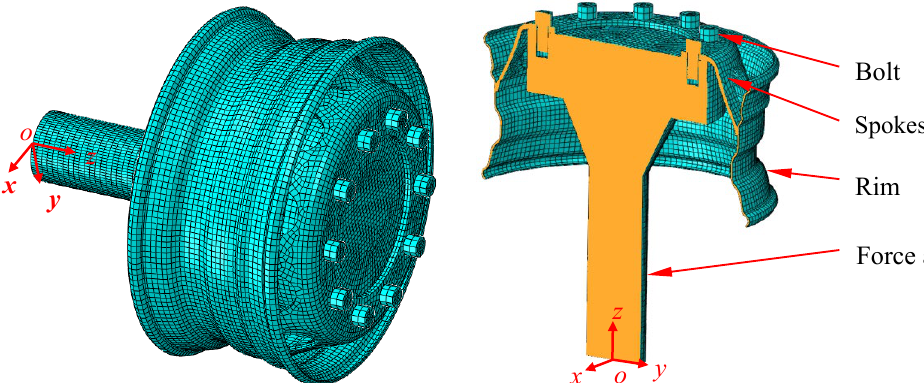
Figure 10. Finite element model of steel wheel.